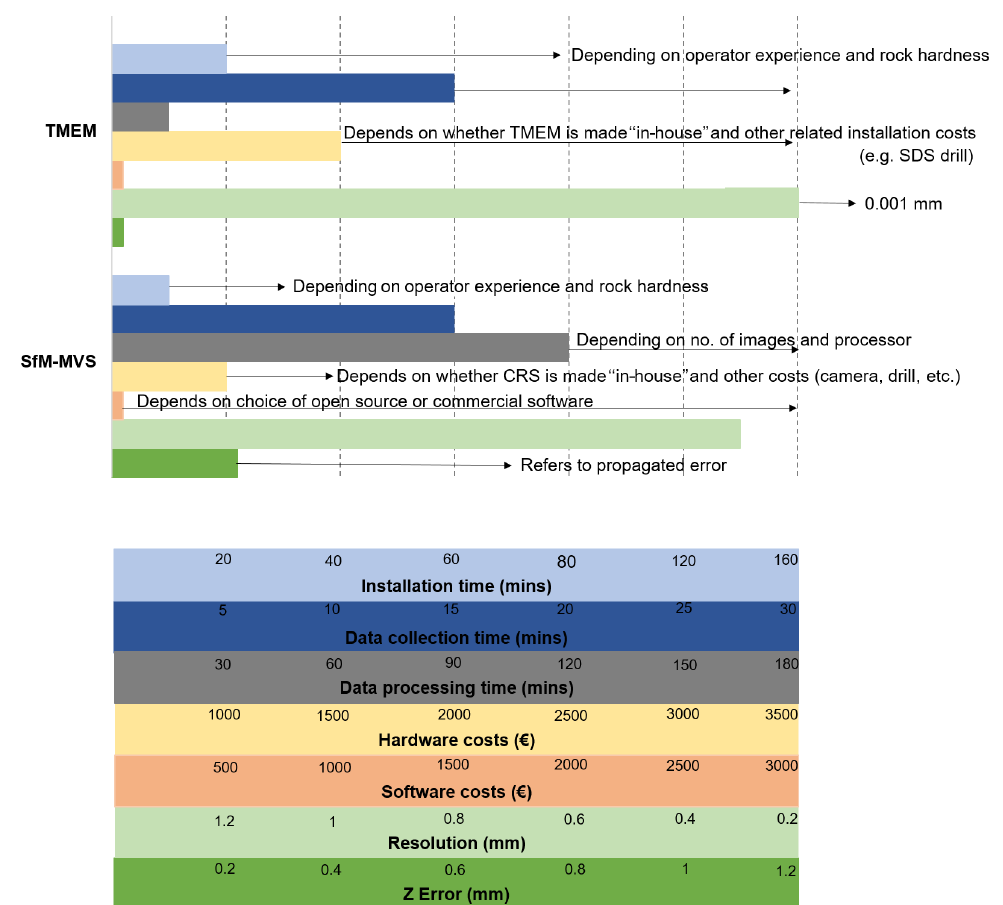
Figure 7. Comparison of TMEM and the SfM-MVS workflow presented in this study under different categories. Values shown (cost, time, etc.) increase from left to right apart from “resolution” for which decreasing values from left to right indicate increasing